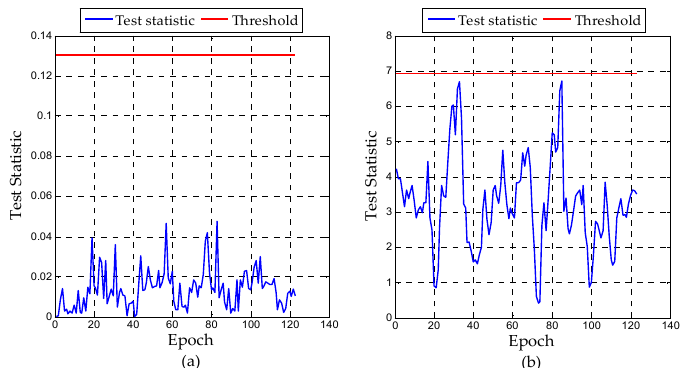
Figure 15. ( a ) The Test Statistics of CRAIM after PL8 is excluded, (b ) The Test Statistics of PRAIM after PL8 is excluded.